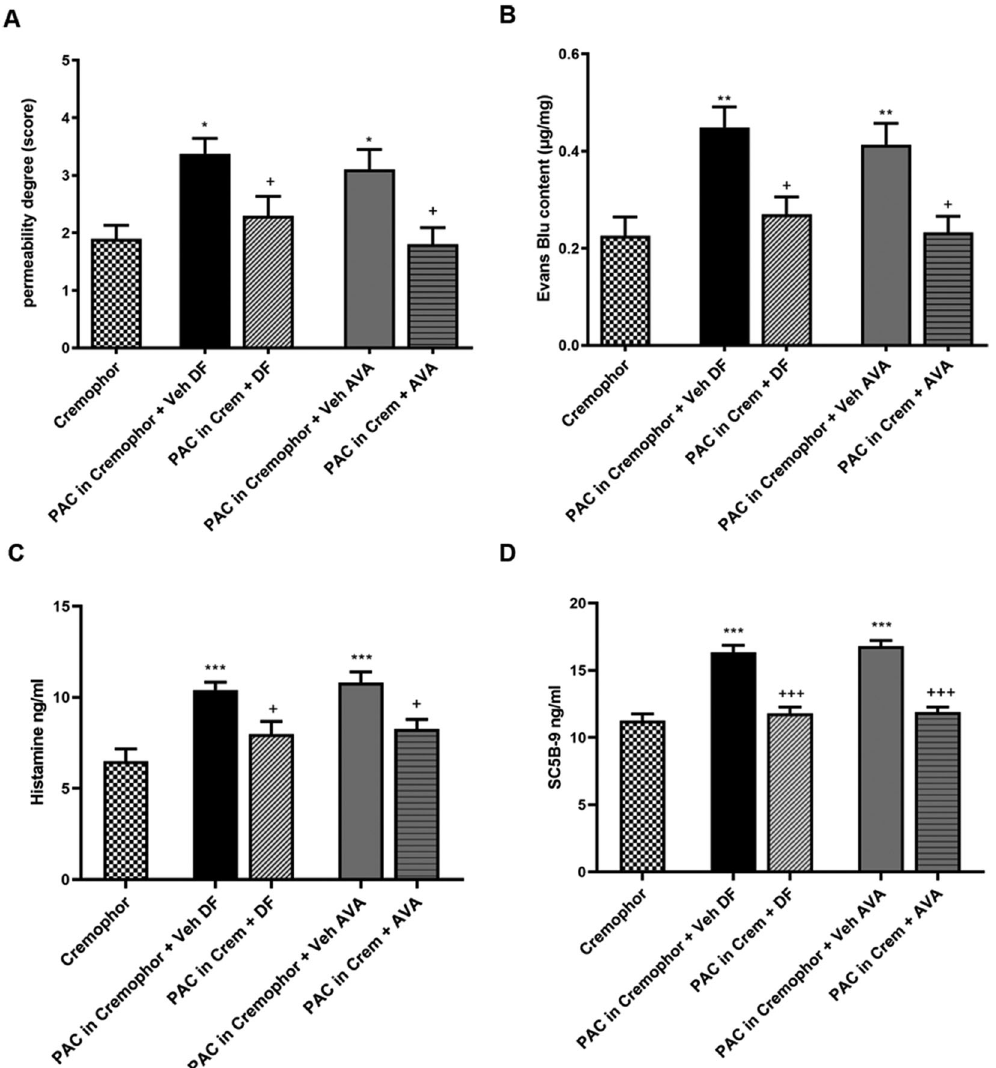
Fig. 8 C5aR1 inhibition prevents anaphylactoid reactions induced by paclitaxel in mice. Effect of vehicle, DF3966A or Avacopan on paclitaxel-increased vascular permeability ( A ) (one-way ANOVA, effect of treatment F (4, 44) = 5.121; p = 0.0018 followed by Bonferroni ’ s multiple comparisons test) and plasma extravasation ( B ) (one-way ANOVA, effect of treatment F (4,44) = 7.258; p = 0.0001 followed by Bonferroni ’ s multiple comparisons test) in mice. Serum histamine (one-way ANOVA, effect of treatment F (3,36) = 7.590; p = 0.0005 followed by Bonferroni ’ s multiple comparisons test) ( C ) and SC5B-9 (one-way ANOVA, effect of treatment F (3,36) = 24.74; p < 0.0001 followed by Bonferroni ’ s multiple comparisons test) ( D ) concentration in mice receiving paclitaxel pre-treated with vehicle, DF3966A or Avacopan. Paclitaxel was intravenously administered at 20 mg/kg. Vehicle DF3966A (saline) and DF3966A (30 mg/kg, os) were administered 3 h before paclitaxel, while vehicle Avacopan and Avacopan (30 mg/kg, os) were administered 1 h before paclitaxel. *** P < 0.0005, **P < 0.005 and * P